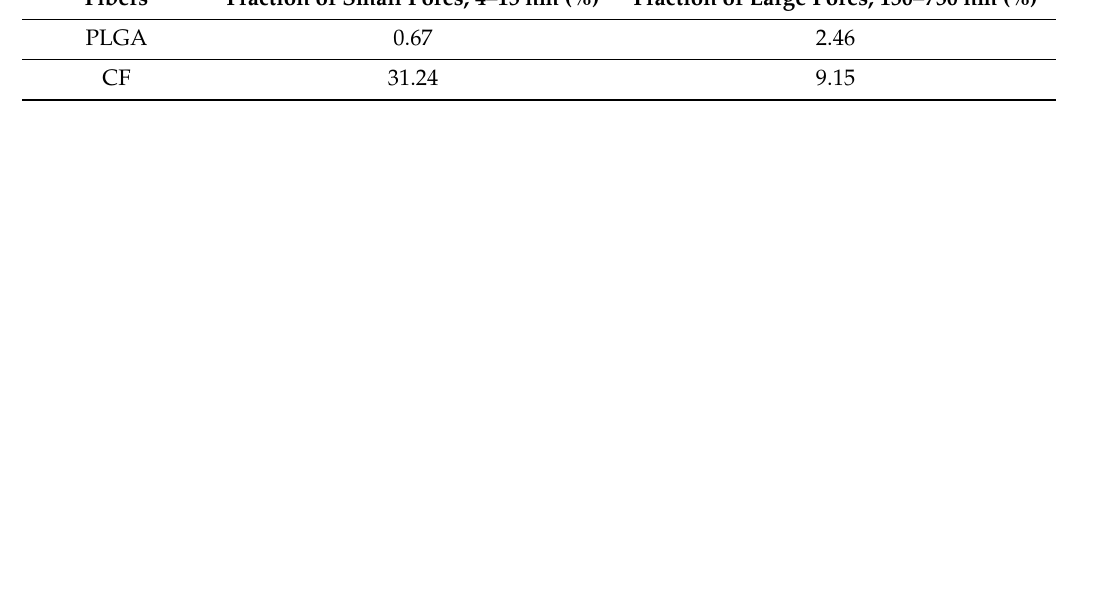
Table 1. Porosimetric data of CF and PLGA fibers .